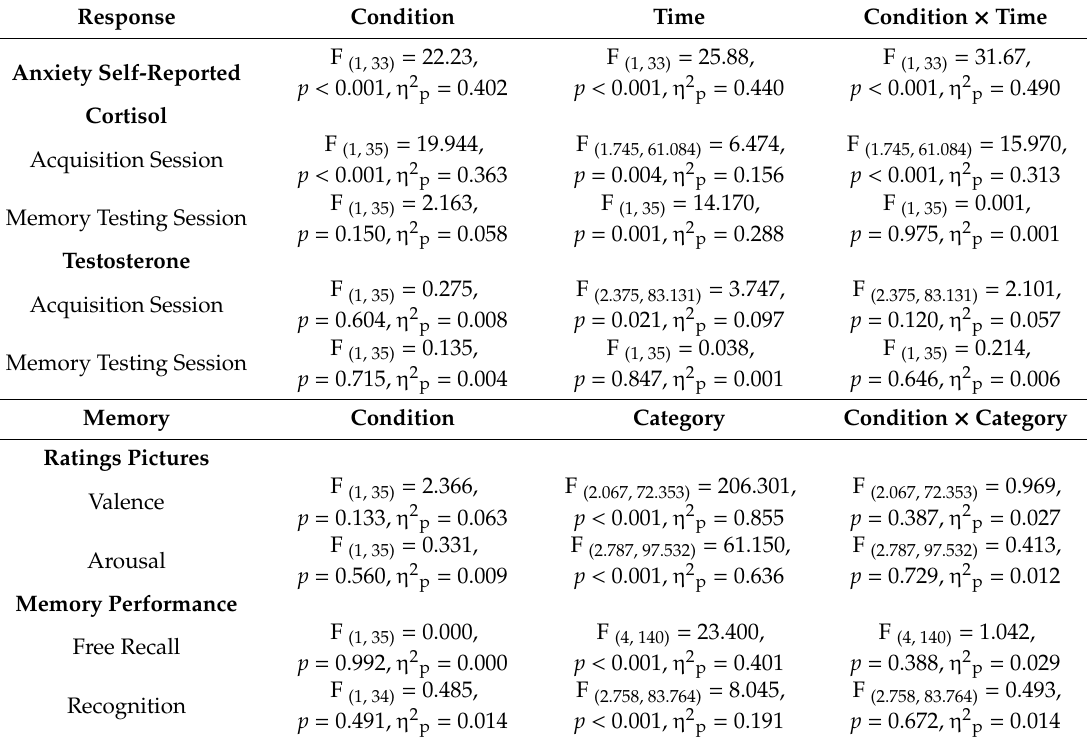
Table 1. Summary of mixed ANOVAs.